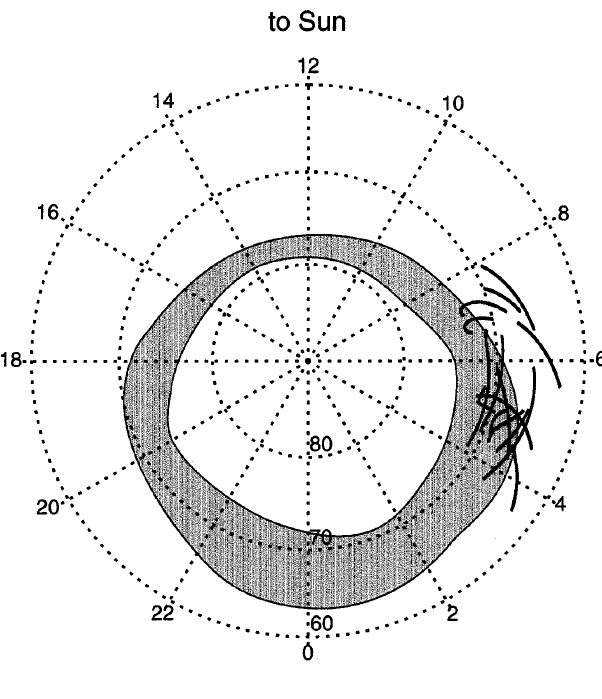
Fig. 13. Traces of the orbital segments shown in Fig. 13 in the northern polar ionosphere superposed on the statistical auroral oval of